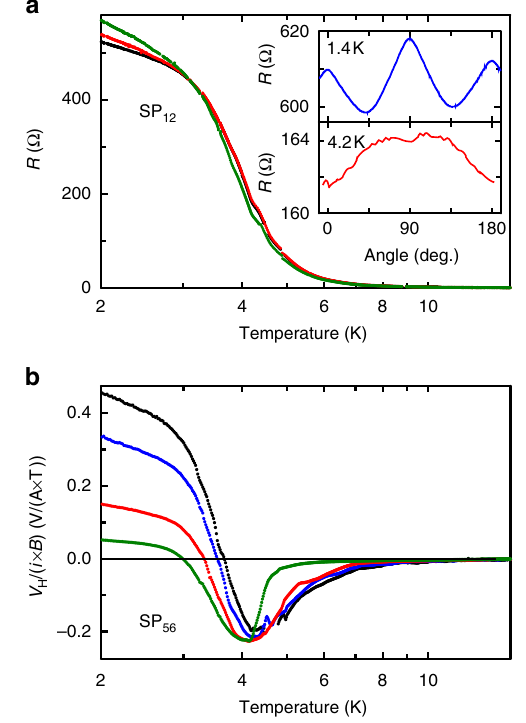
Fig. 2 Electrical transport properties of pristine SmB 6 samples. a Resistance R fi elds of 0 T (black), 6 T (red), xx as a function of temperature in magnetic and 15 T (green). In the high-temperature regime above 5 K the bulk dominates transport; at low temperatures below about 3 K, the surface dominates. Inset: angle dependence of the 15 T magnetoresistance in the low-temperature regime (upper, blue) and at intermediate temperatures (lower, red) showing the difference in the forms of the magnetoresistance characteristic of surface-dominated and bulk-dominated transport. b The Hall effect V H as a function of temperature in magnetic fi elds of 1 T (black), 2 T (blue), 6 T (red), and 15 T (green). The codes SP 12 and SP 56 indicate the particular sample and voltage contact con fi gurations reported; see Fig. 1c for details of all